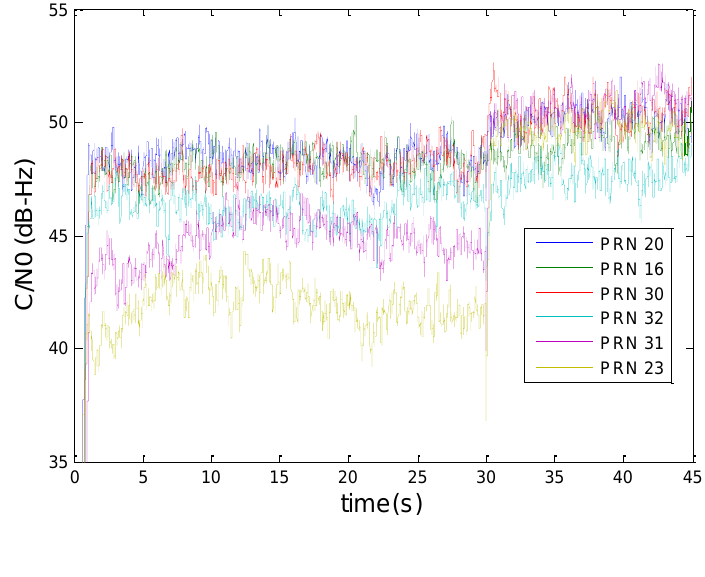
Figure 15. Comparing C/N for a single antenna receiver and the beamformer for PRNs 0 20, 16, 30, 32, 31 and